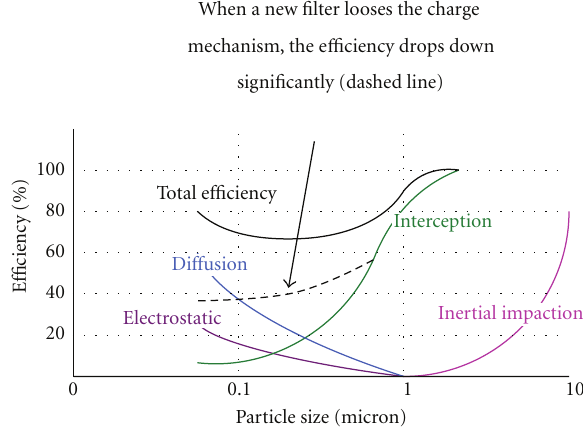
Figure 2: Combination of filtration mechanisms to obtain filter e ffi ciency at various particle sizes